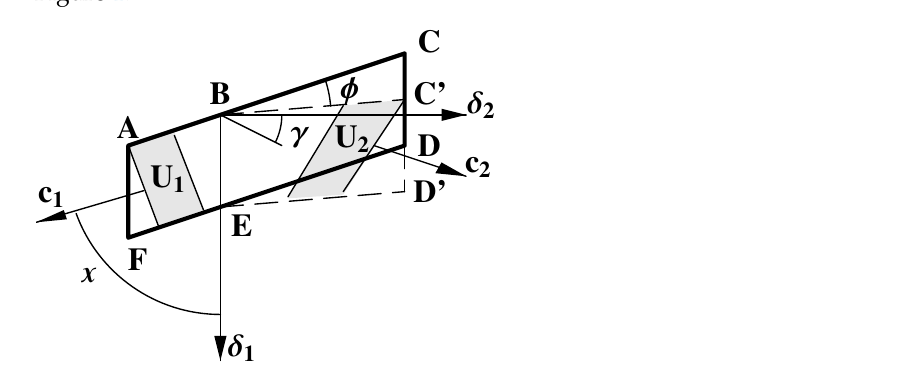
Figure 1. The process of twin formation with a simple shift of part of one of the martensite plate in the direction of the δ 1